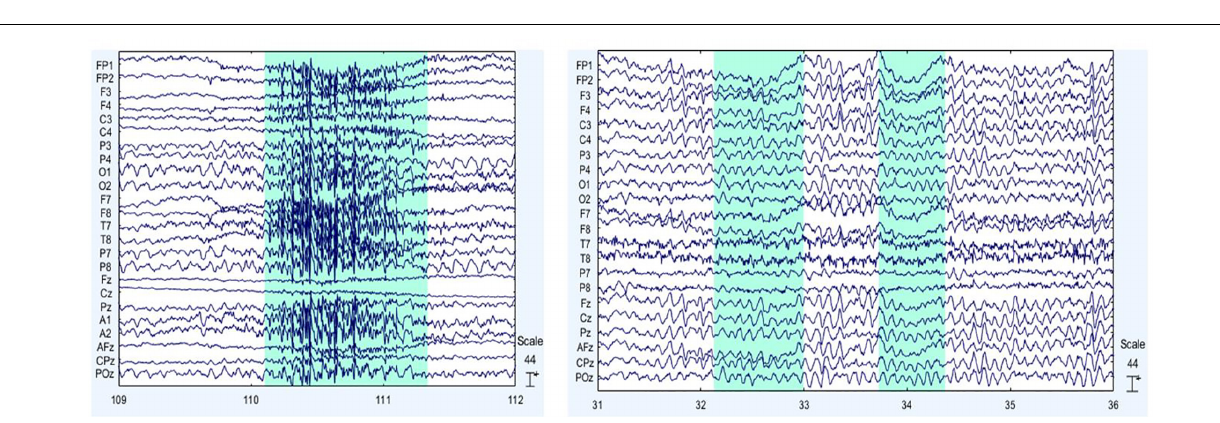
FIGURE 3 | Main EEG artifacts are ocular and muscular electrical activity. On the left (A) , muscular artifacts are shown, and on the right (B) , ocular artifacts are presented. The sections shaded in blue indicate examples of the muscular (on the left) and eye (on the right) artifacts